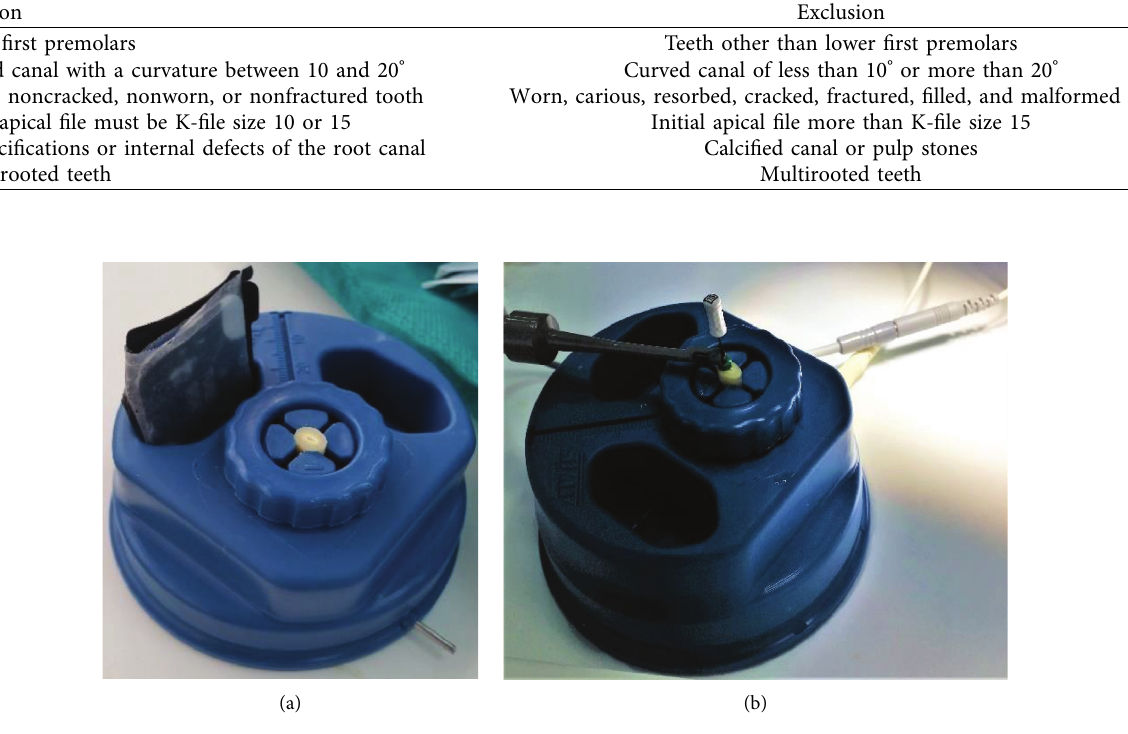
Figure 2: Protrain mold designed to simulate the oral environment of the extracted teeth.